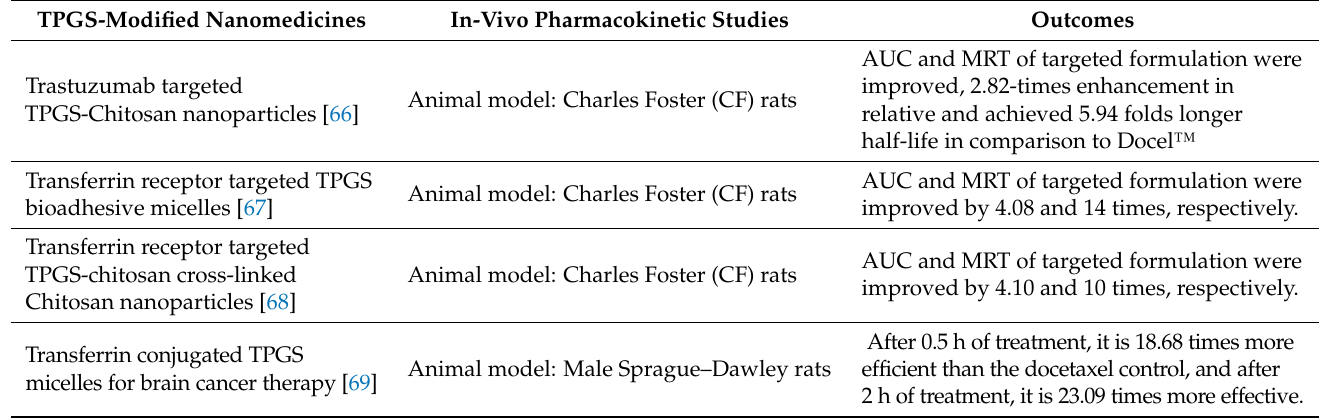
Table 1. Pharmacokinetic outcomes of several docetaxel-loaded TPGS-modified nanomedicines administered intravenously at the concentration of 7.5